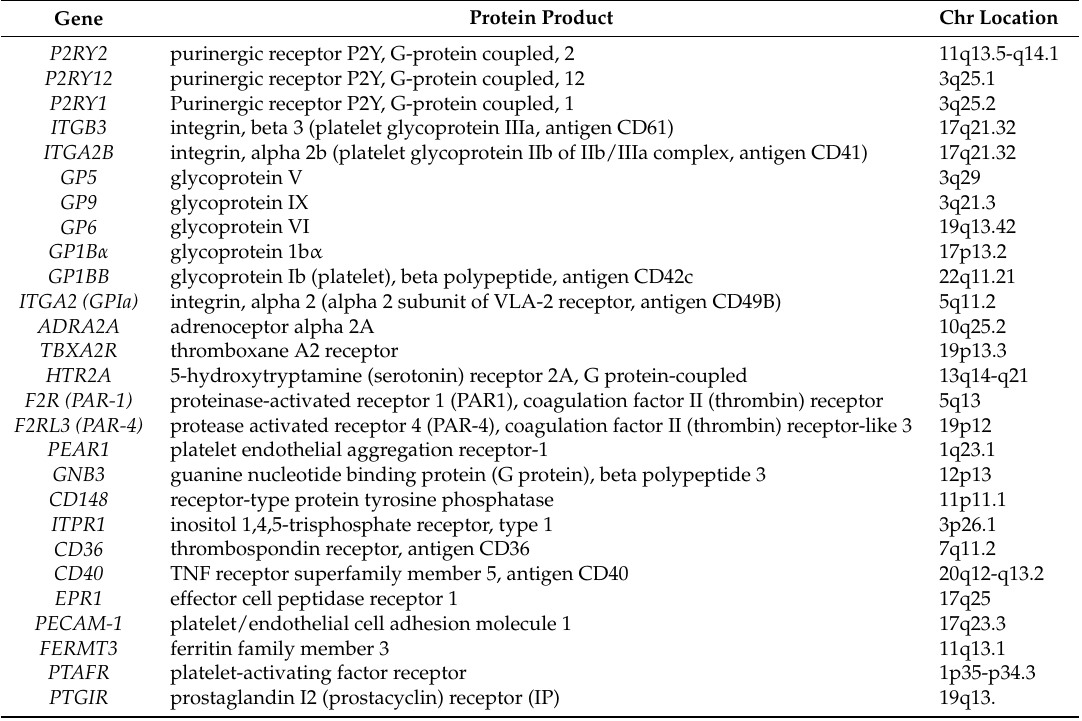
Table 3. List of sequenced genes involved with the platelet membrane